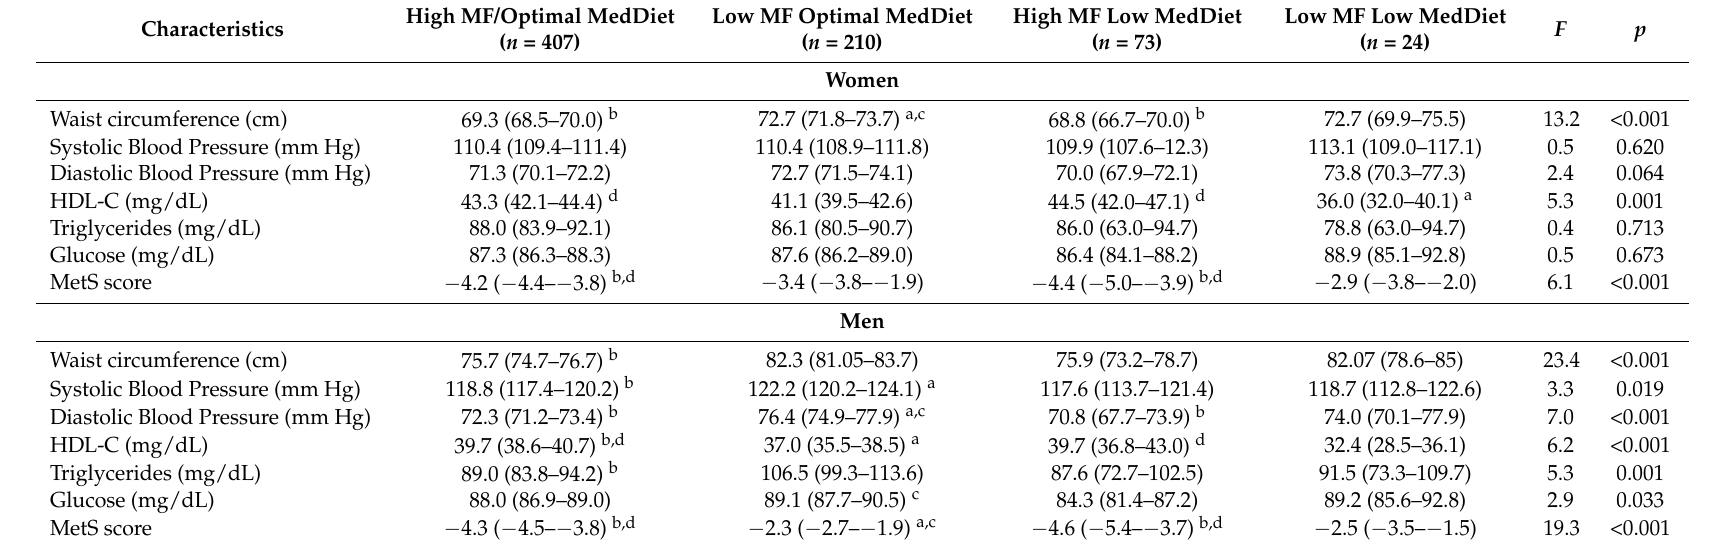
Table 2. Cardiometabolic risk variables for women across combined groups of adherence to a MedDiet (low adherence vs. optimal adherence), and muscular fitness (low muscular fitness vs. high muscular